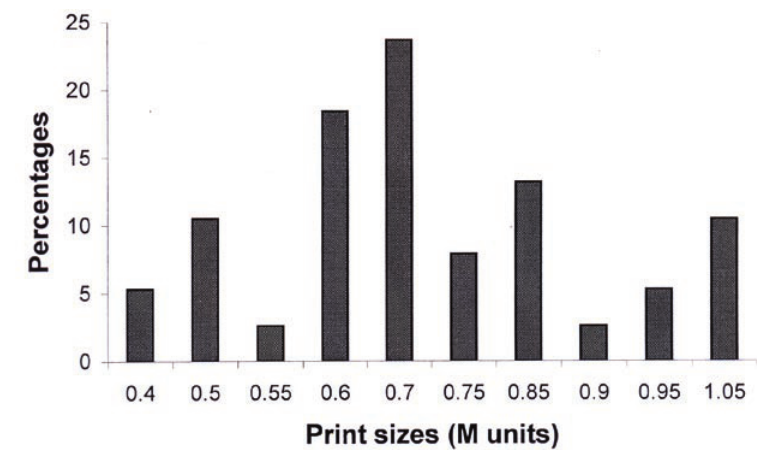
Figure 1. Distribution of print sizes in the advert sections of the newspapers. There is a wide variation of print sizes in this section of the newspapers. The most common sizes were 0.6M and 0.7M.